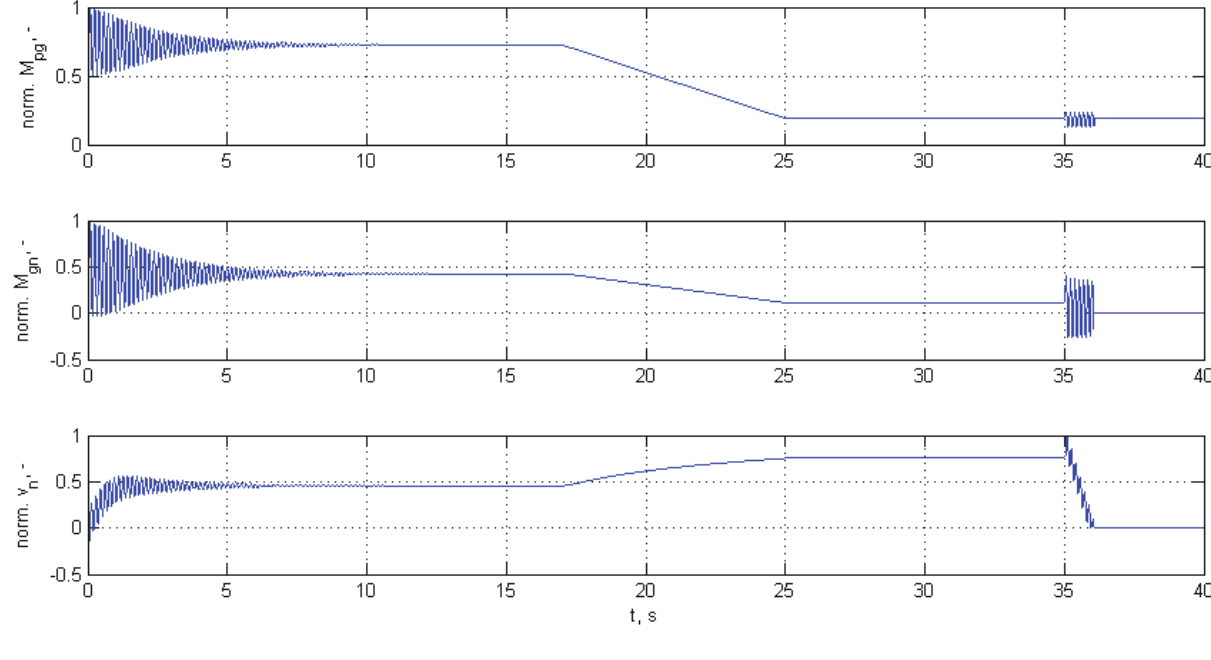
Fig. 7. Results of simulation following the scenario: run-up with excavated material, unloading, run-down (S6)